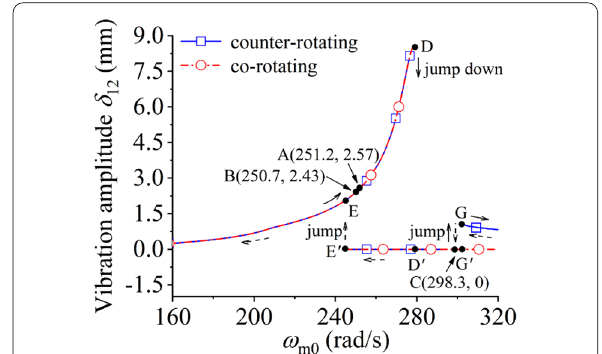
Figure 5 Relative vibration amplitude versus ω